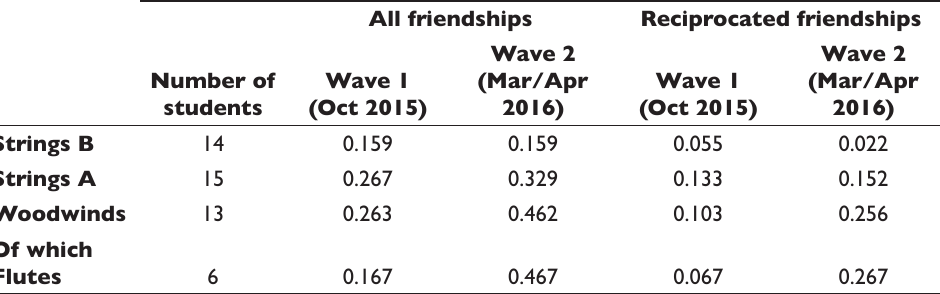
Woodwinds Of which Flutes 6